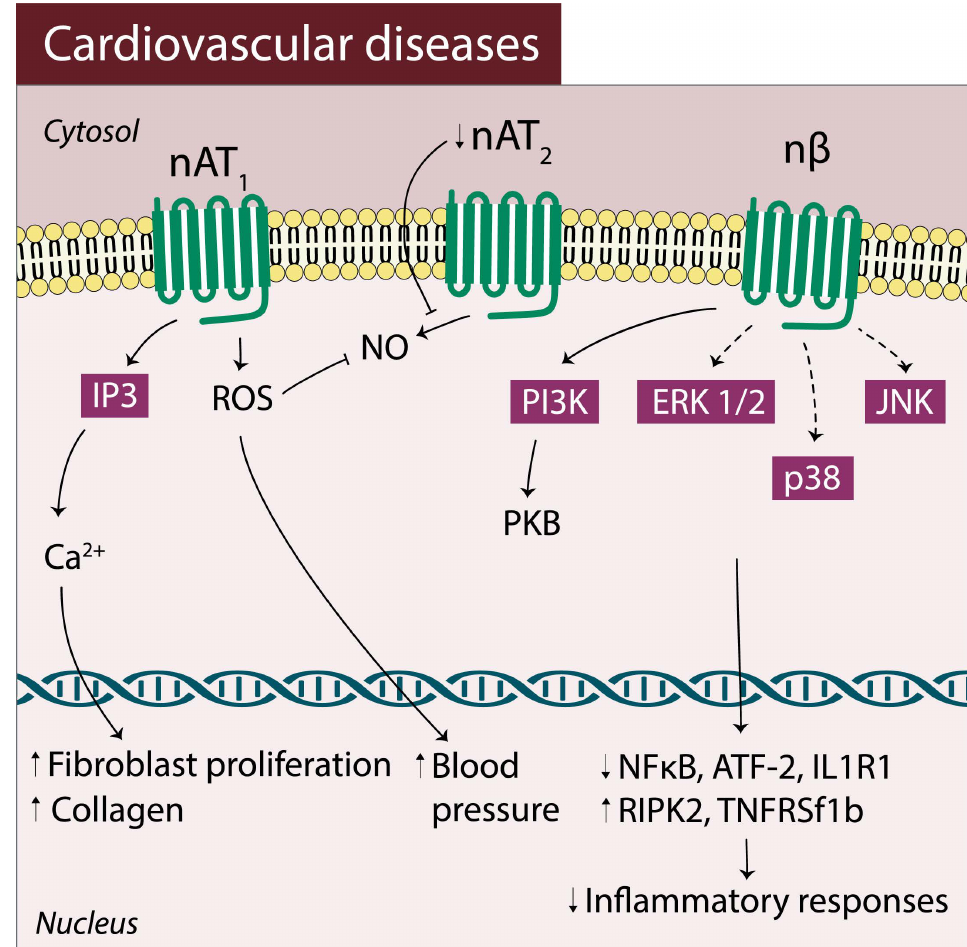
Figure 4. Atypical pathways involving nuclear GPCRs in cardiovascular diseases: nAT 1 and nAT 2 receptor and nuclear β -adrenoceptor (n β ) activated signaling pathways in cardiovascular